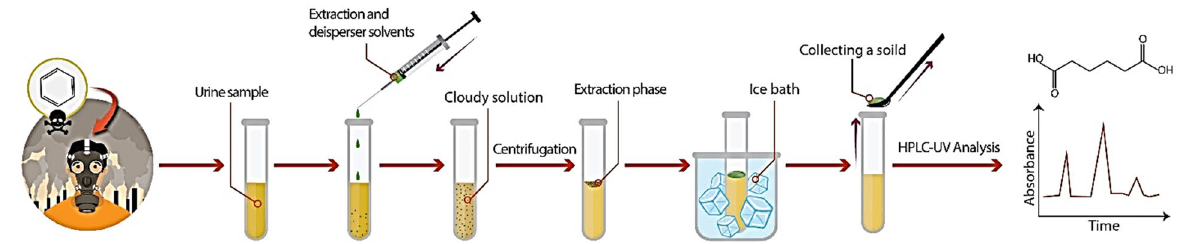
Figure 1. A schematic diagram of the utilized DLLME-SDOD